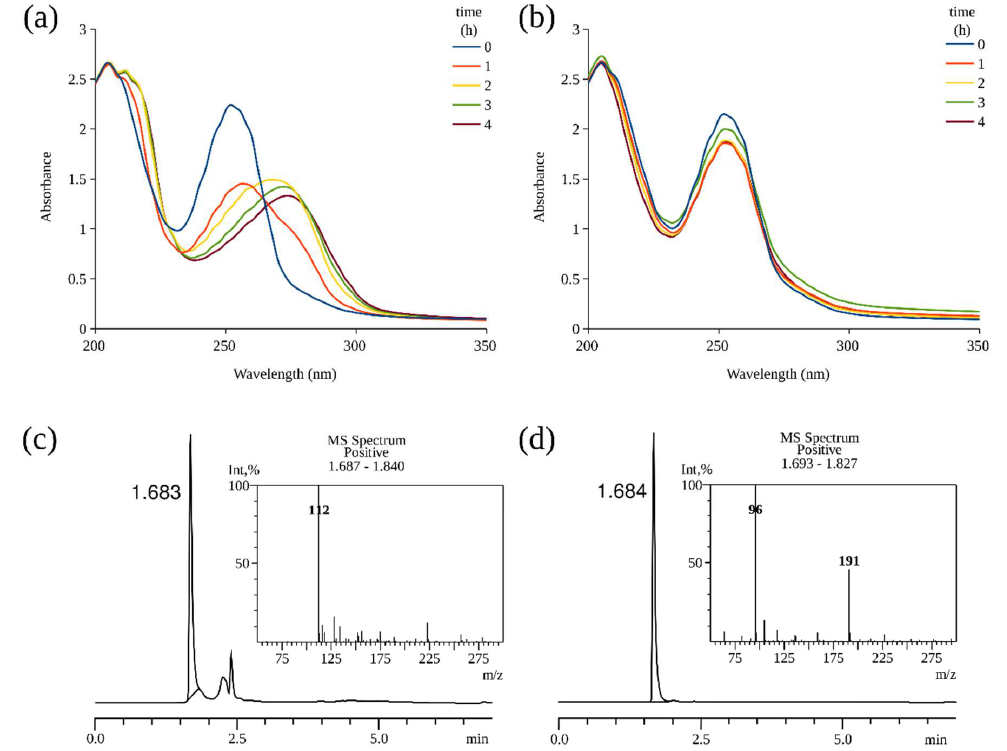
Figure 2. Bioconversion of 4HP in Rhodococcus erythropolis SQ1 transformed with recombinant pNit- kpiA plasmid ( a , c ), and wild-type R . erythropolis SQ1 ( b , d ). Cultures of R . erythropolis SQ1 were incubated in potassium phosphate buffer supplemented with 1 mM 4HP, and the UV-VIS absorption spectra were recorded ( a , b ). The lines represent the progress of the reaction (time in hours). The end reaction products (after 4 hours) were analyzed by HPLC-MS ( c , d ).